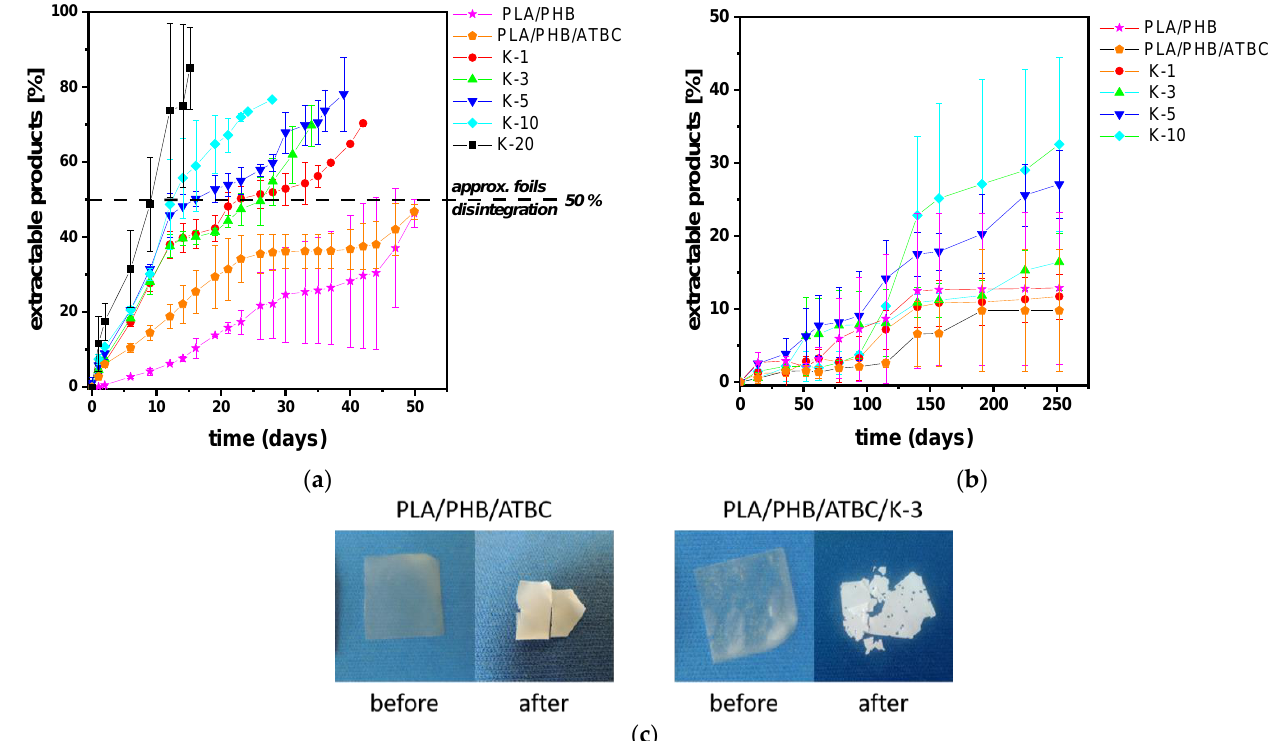
Figure 7. Extractable products during hydrolysis of PLA/PHB/ATBC blend and its keratin composites with different keratin contents varying from 1 to 20 wt%; ( a ) basic hydrolysis in 0.01 M NaOH; ( b ) hydrolysis in pure water; ( c ) representative pictures of PLA/PHB/ATBC blend and PLA/PHB/ATBC/K-3 composite before and after basic hydrolysis in 0.01 M NaOH.